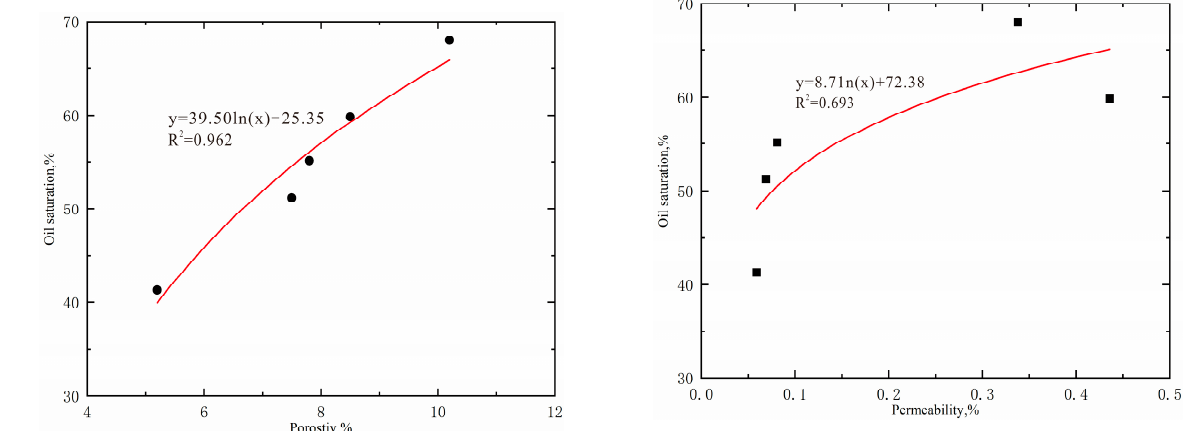
Figure 9. Relation between oil saturation and reservoir porosity, permeability.